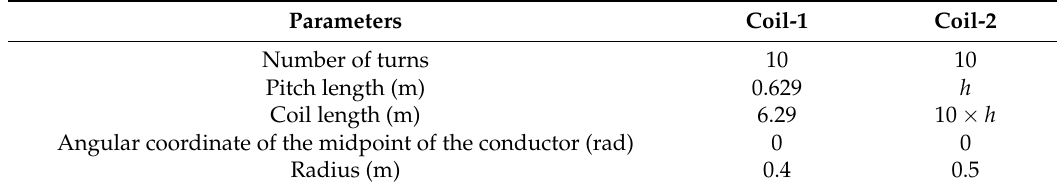
Table 6. Geometric parameters of the coils in Figure 2 (5th